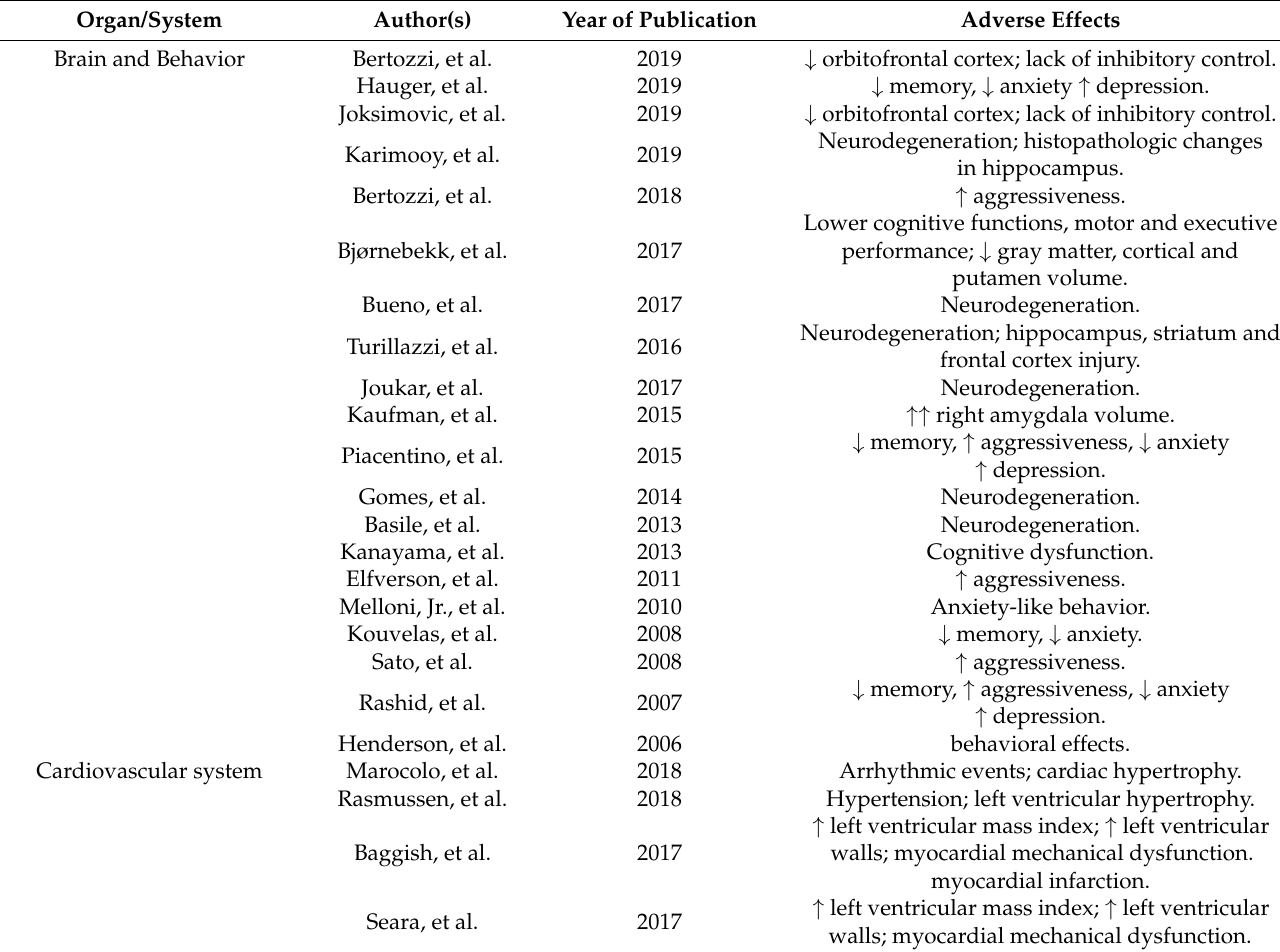
Table 1. Summary of adverse effects of anabolic steroid